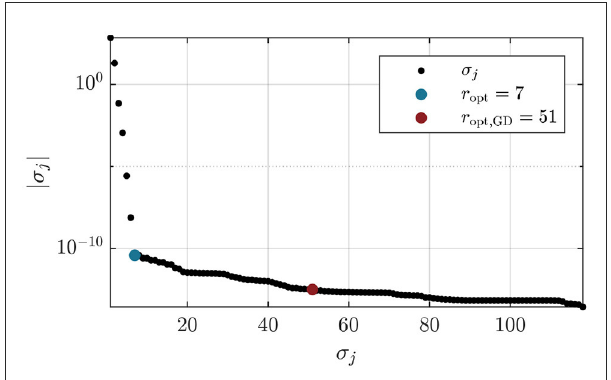
FIGURE3 Determination of model rank r for the double mass oscillator system introduced in Section 3.1. The absolute values of the σ j form an elbow curve. The method proposed in [1] yields the rank r opt,GD = 51 which is much higher than the suitable model rank r opt = 7 determined